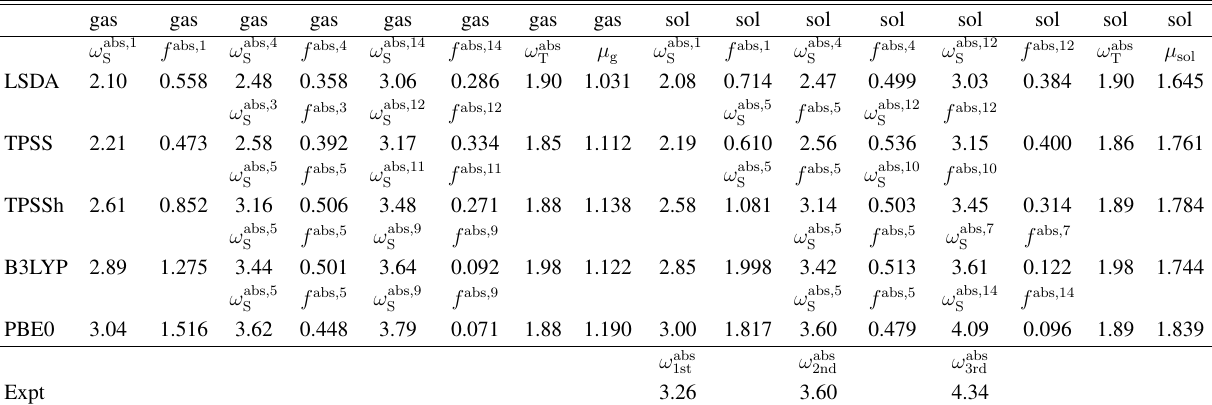
The same as Table 11, but for BPYPQ. The basis set 6-31G(d) is used. Experimental values measured in chloroform are obtained from Ref. [108].